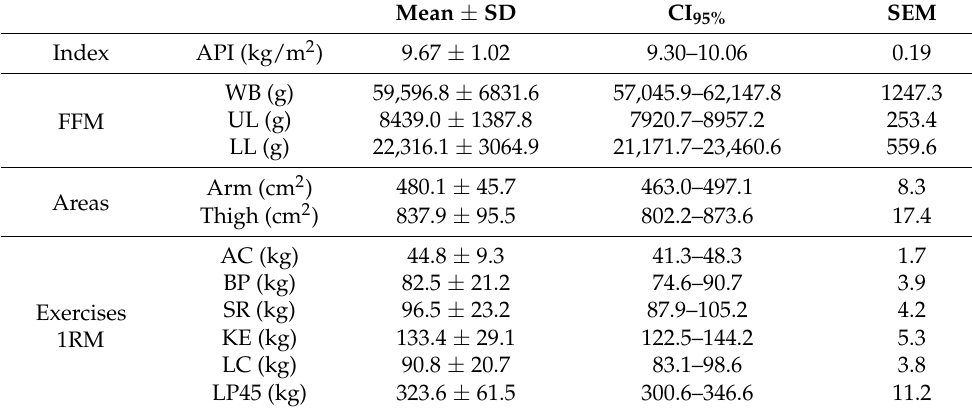
Table 1. Values of regional and whole-body composition, and muscle strength.